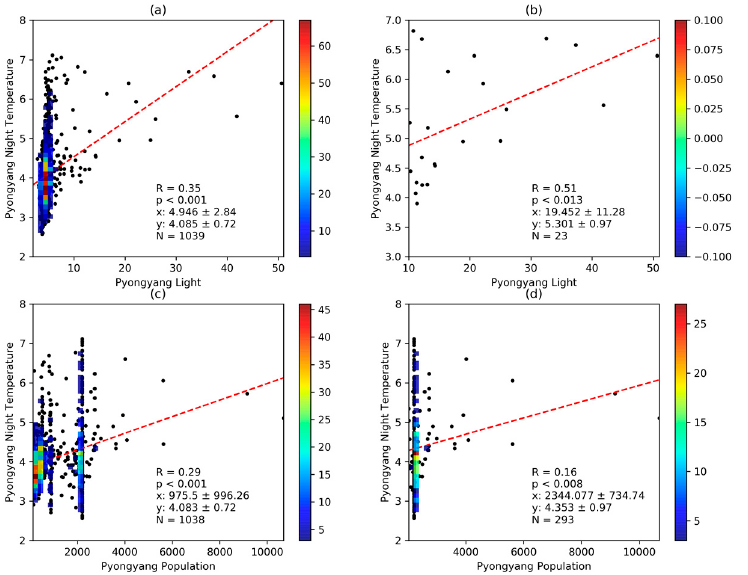
Figure 3. Same as Figure 2 but for Pyongyang. The correlation between the nighttime LST and night light ( a ), the correlation between the nighttime LST and annual mean population over 5 years based on all data ( c ), ( b , d ) are the density distribution for all night light values larger than 10 nW/(cm 2 str) and with a population level larger than 2000 per